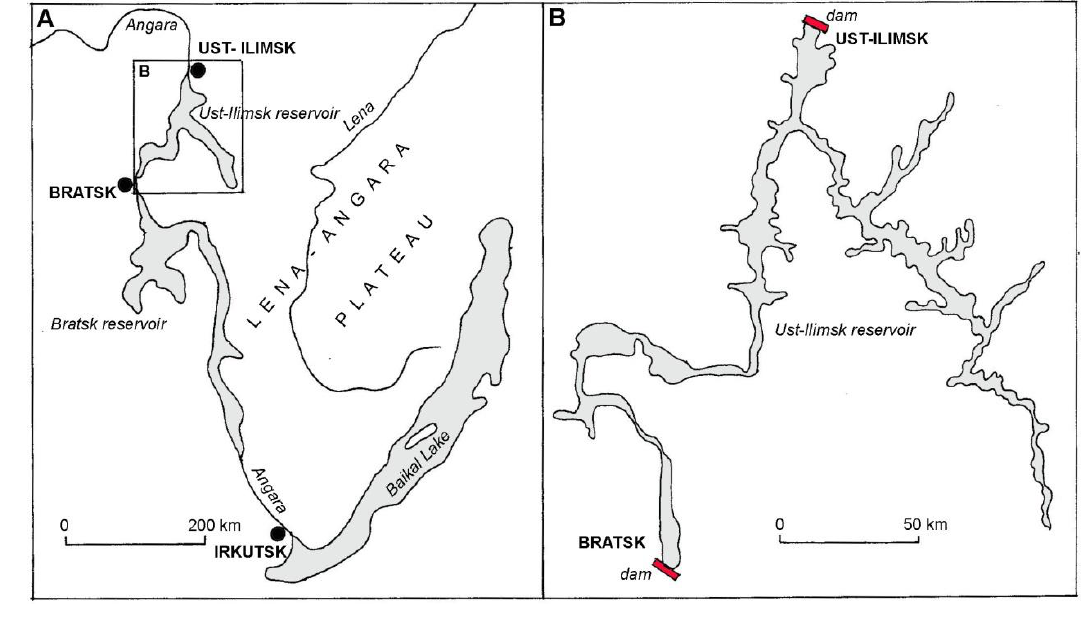
Fig. 1. Location of the Ust-Ilim reservoir (after Tashlykova, 2013a)